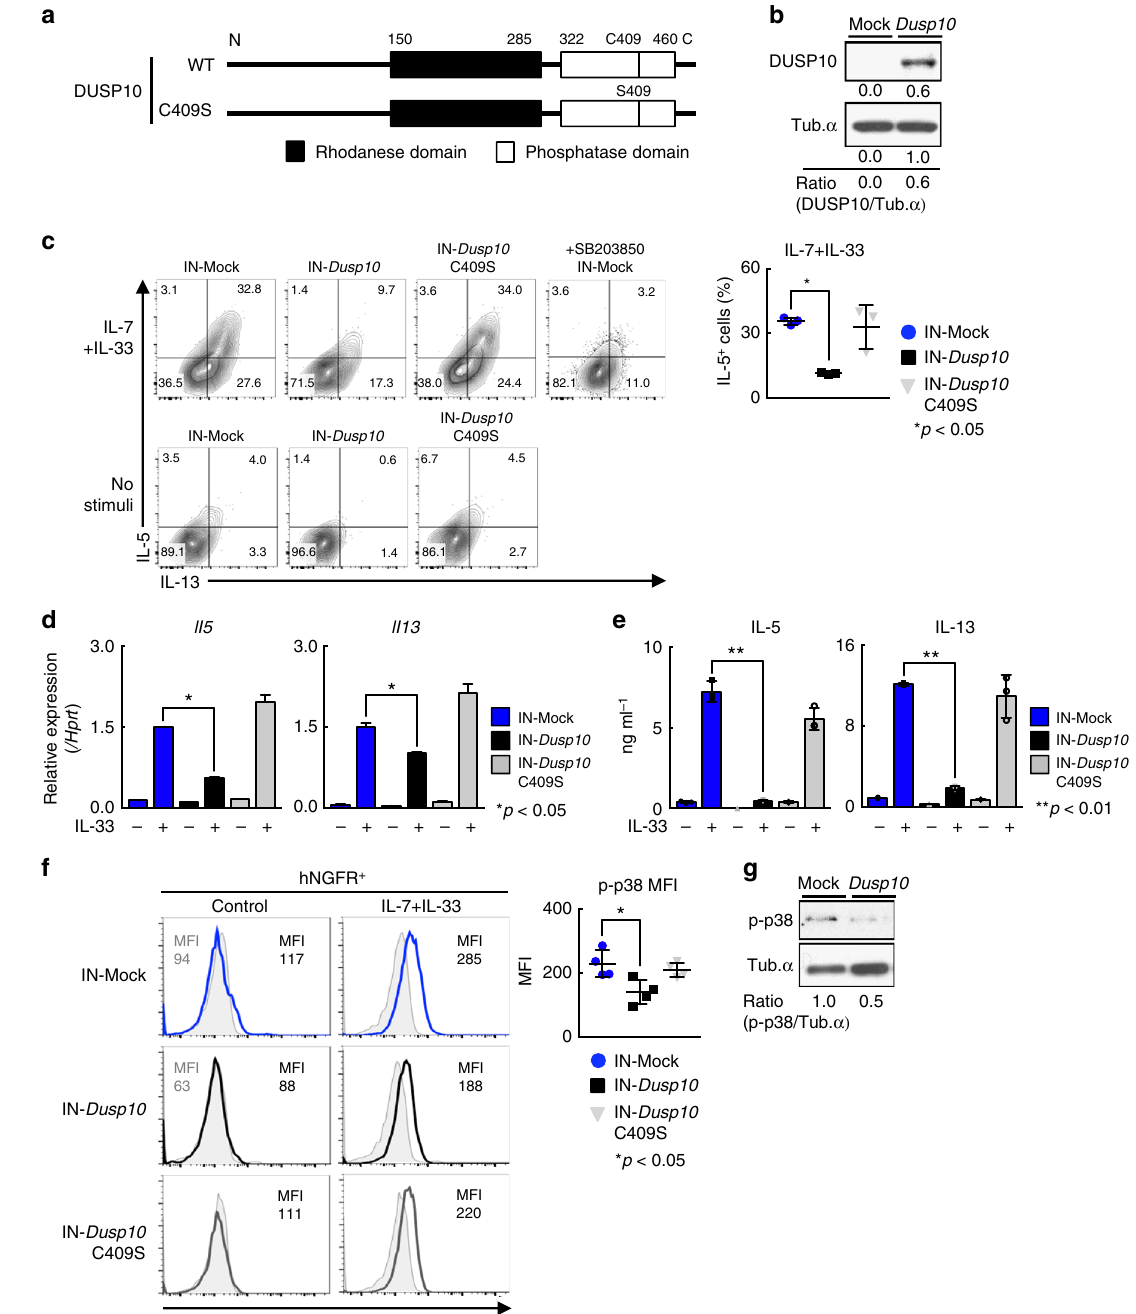
Fig. 4 Induction of Dusp10 suppresses IL-5 production in ILC2. a Schematic representation of wild-type Dusp10 (WT) and C409S mutant. b – g